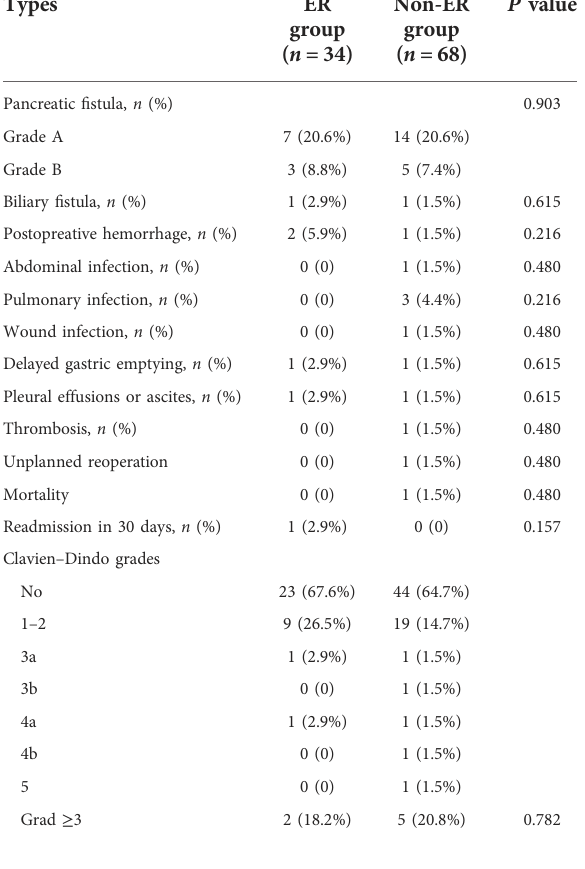
TABLE 4 Surgical complications. 12 Surgical complications were used to compare between two groups including pancreatic fi stula, biliary fi stula, postopreative hemorrhage, abdominal infection, pulmonary infection, wound infection, delayed gastric emptying, pleural effusions or ascites, thrombosis, unplanned reoperation, mortality, readmission in 30